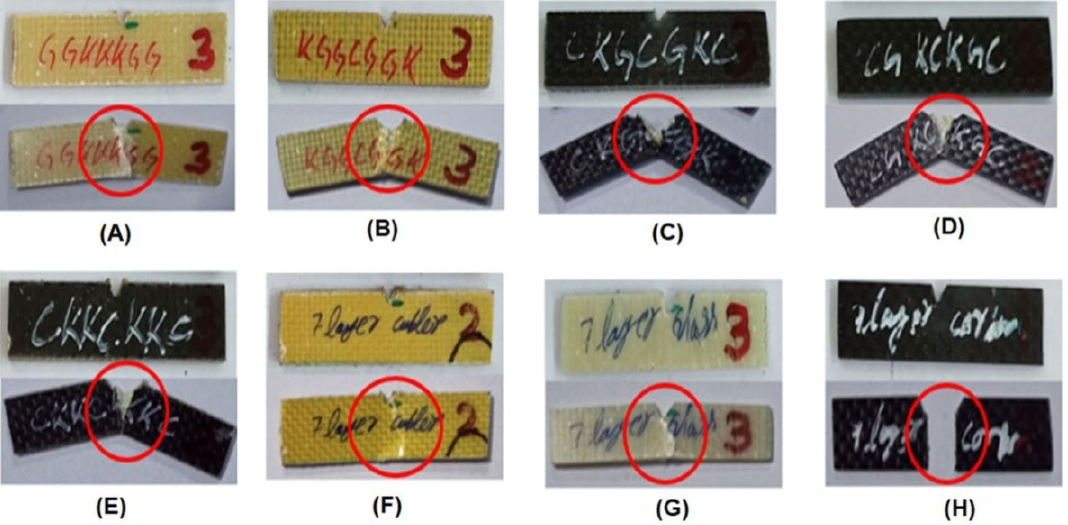
Figure 7. Izod impacted composite tested samples of composite type A, B, C, D, E, F, G and H.